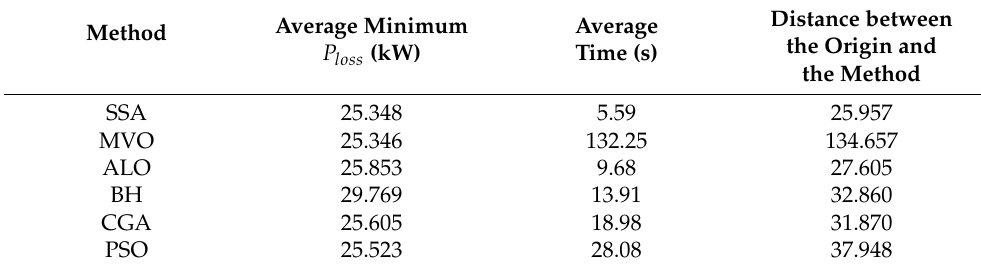
Table 9. Mean average power losses vs. average time in the 69-node